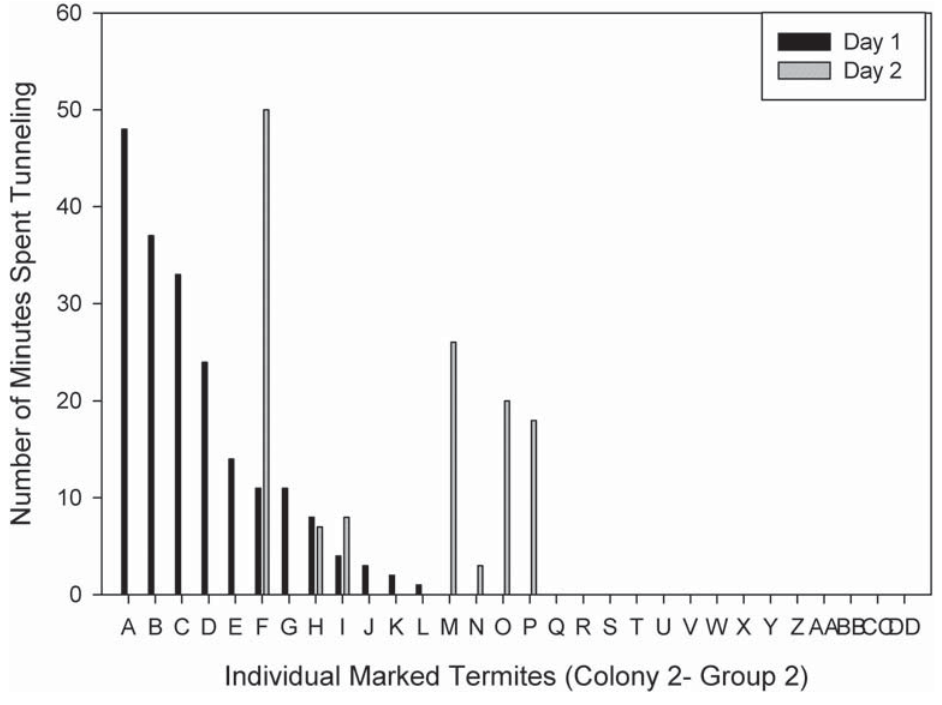
Figure 5. The number of minutes spent tunneling by each individual marked termite in Colony 2-Group 2 on Day 1 and Day